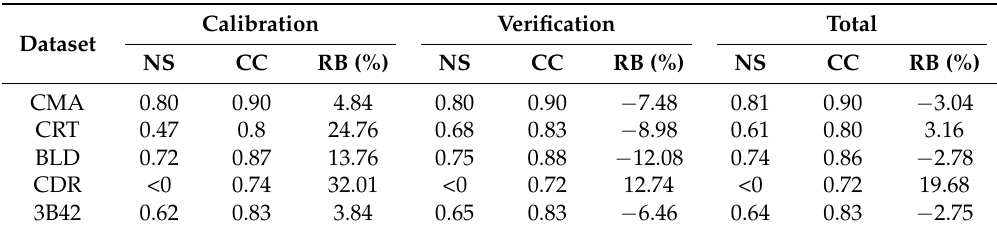
Figure 6. Observed and simulated streamflow forced by CMA data for the UYRB for the calibration period (2001–2005) and verification period (2006–2012). Table 2. The statistical indicators for simulated streamflow forced by CMA data and four SGPEs versus the observed streamflow during calibration (2001–2005), verification (2006–2012) and the total (2001–2012)